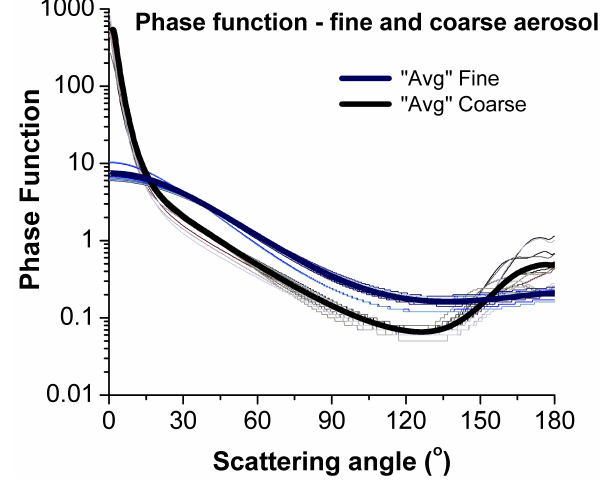
Fig. 3. Phase functions at 440nm for fine (blue) and coarse (grey) aerosol determined for 4 distinct aerosol types: Urban (Urb), Biomass Burning (BB), Desert Dust (DD) and Oceanic. Opti- cal properties taken from 12 AERONET stations (Dubovik et al., 2002): Paris/Creteil – France (Urb), GSFC/Maryland – USA (Urb), Maldives (Urb), Mexico city – Mexico (Urb), Amazonian Forest – Brazil (BB), South American cerrado – Brazil (BB), African sa- vanna – Zambia (BB), Boreal forest – USA and Canada (BB), Cape Verde (DD), Persian Gulf (DD), Saudi Arabia (DD) and Lanai (Oceanic). Average of phase functions for each of the aerosol sizes considered is presented in thick lines (blue for fine and black for coarse